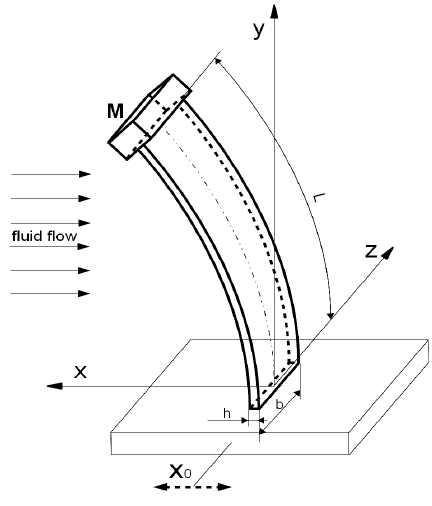
Fig. 1. Model of the nonlinear beam with self- and external